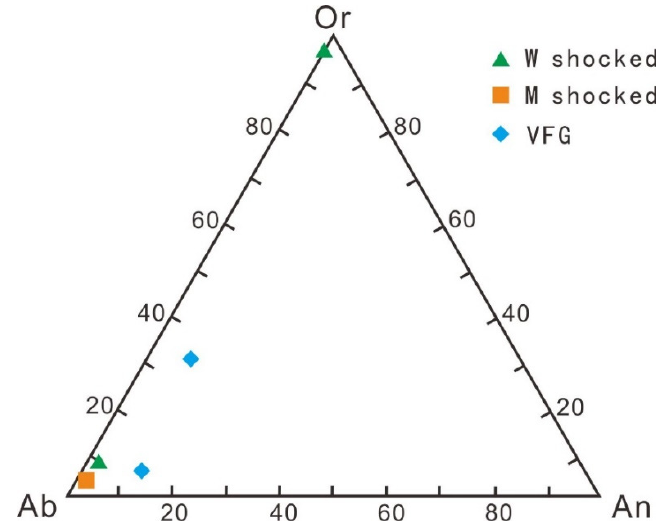
Figure 4. Ternary diagram for feldspars. Green symbol—weakly shocked feldspar (W shocked), Yellow symbol—moderately shocked feldspar (M shocked), Blue symbol—vesicular feldspar glass (VFG). Ab—albite, An—anorthite, Or—orthoclase.